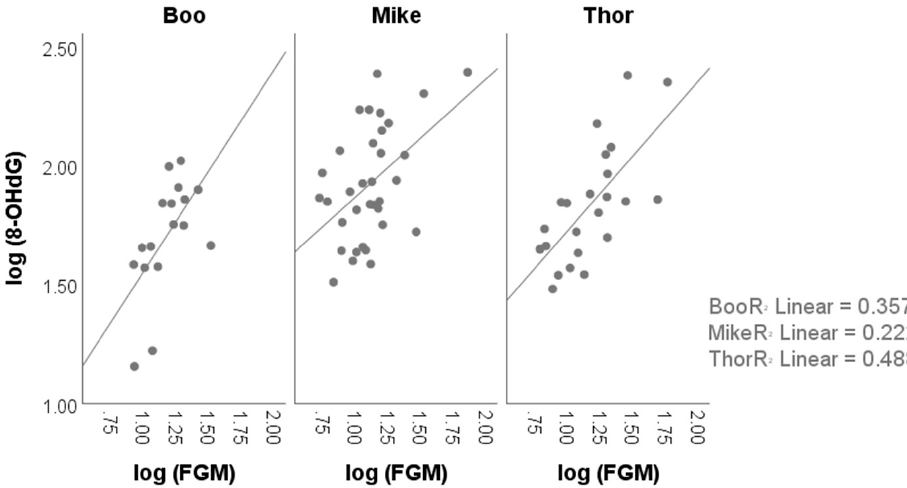
Figure 2. Longitudinal concentrations of fecal glucocorticoid metabolites (FGM) and fecal oxidized guanine (8-OHdG) in three male grizzly bears while they occupied a temporary, smaller habitat. Concentrations are expressed as ng/g dry feces. Note the different scales on the graph for Boo ( a ) compared to Mike ( b ) and Thor ( c ).